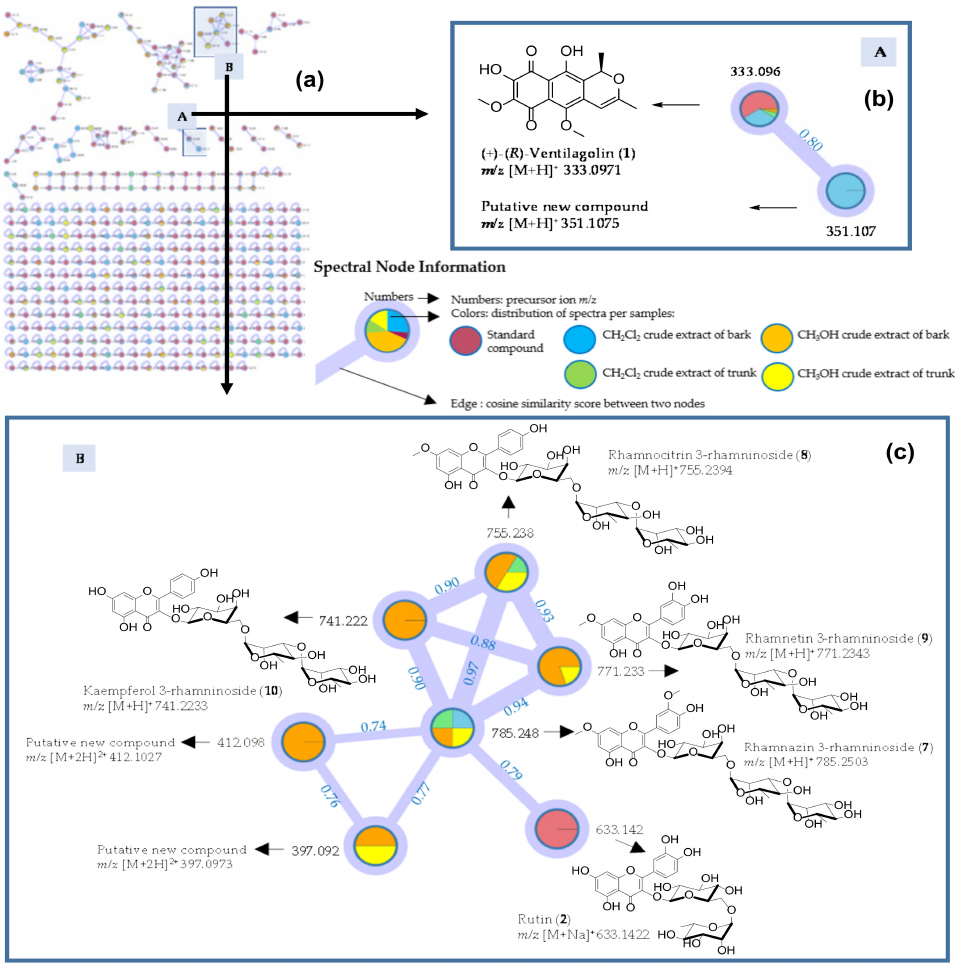
Figure 1. Molecular networking of crude extracts of V. denticulata as a complementary method for the dereplication strategy: ( a ) Molecular networking of crude extracts in a positive ionization mode; ( b ) Molecular networking connected to ( + )-( R )-ventilagolin ( 1 ) and a putative new naphthalene derivative found in CH 2 Cl 2 crude extract of bark; ( c ) Molecular networking connected to rutin ( 2 ) and other flavonol glycosides found in MeOH crude extract of